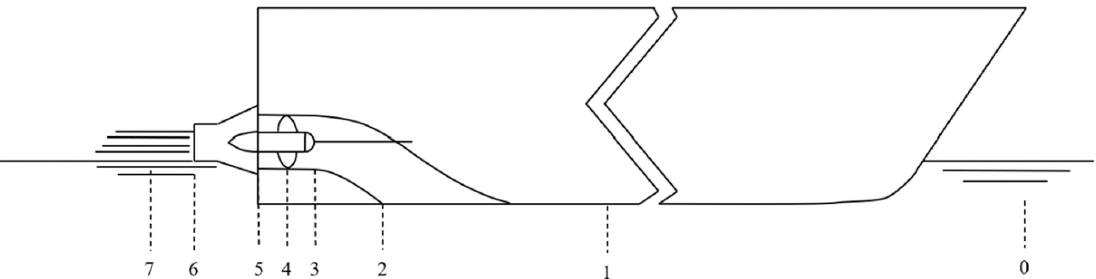
Figure 21. A sketch of the different stations of the catamaran.